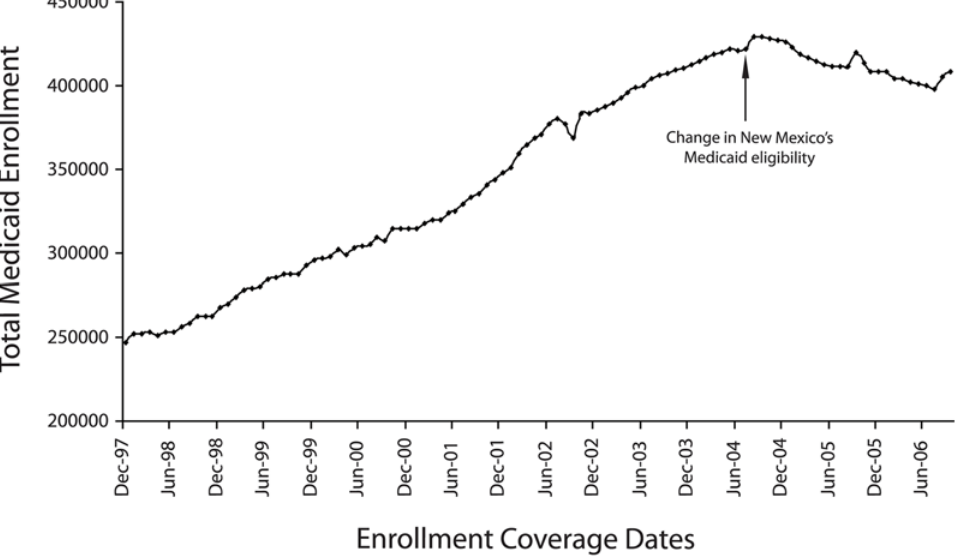
Figure 1. Total Medicaid enrollment levels between 1997 and 2006.